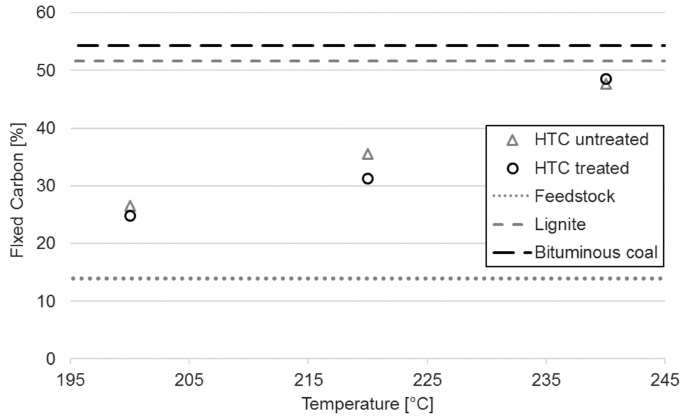
Figure 6. Fixed carbon of hydrochar samples as a function of reaction temperature for untreated and treated